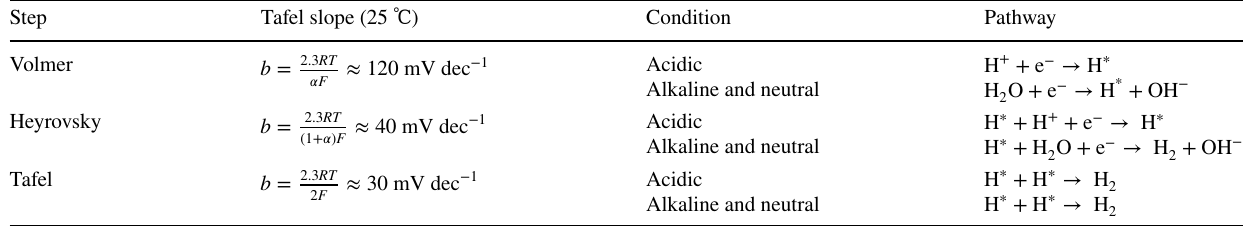
R , Ideal gas constant; T , Kelvin temperature; α , Symmetrical coefficient, 0.5; F , Faraday